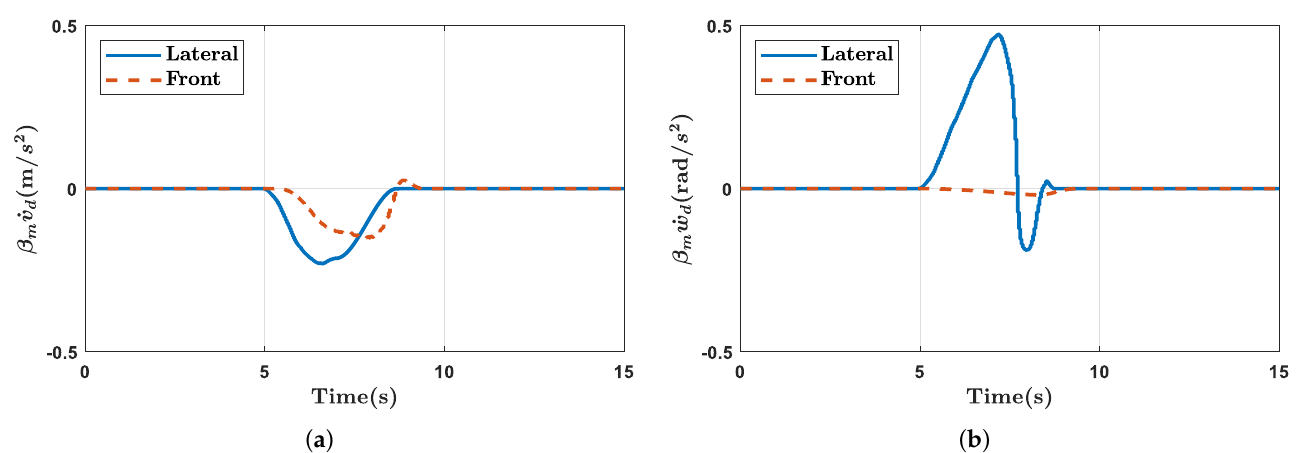
Figure 15. Experimental results of self-collision avoidance while manually guiding the end-effector. ( a ) The desired linear accelerations multiplied by activation parameter; ( b ) the desired angular accelerations multiplied by activation